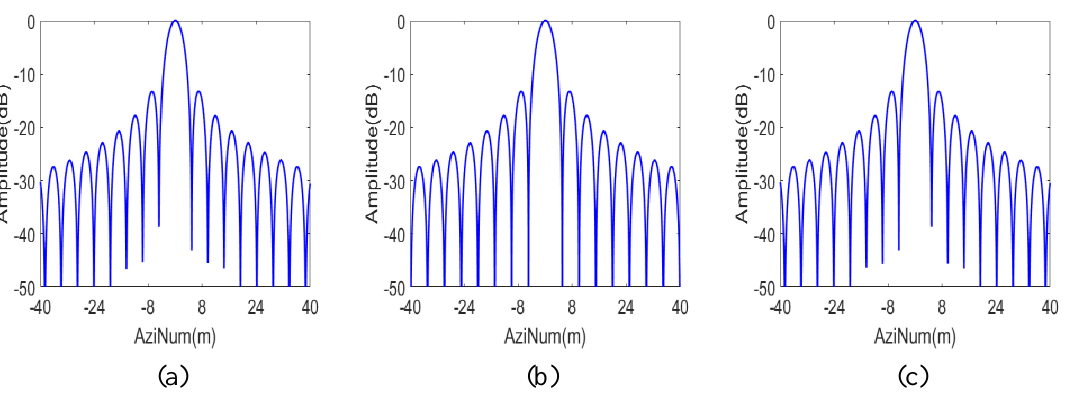
Figure 8. Azimuth profile of the targets of the proposed scheme. ( a ) Target A; ( b ) Target B; and ( c ) Target